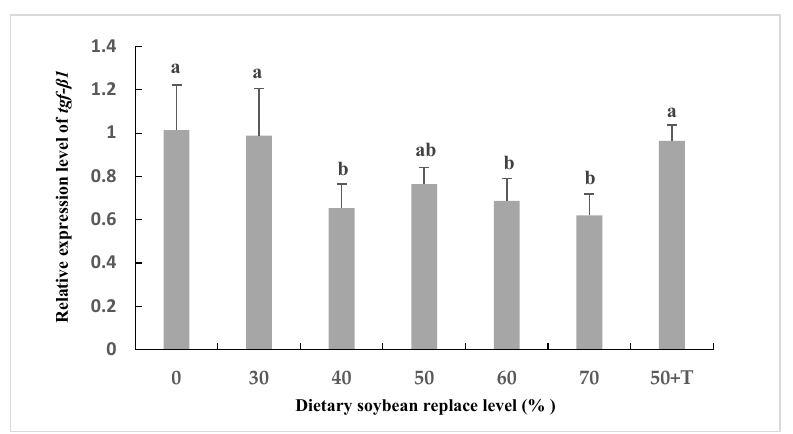
Figure 3. Relative expression of the mRNA for transforming growth factor β 1 ( tgf- β 1 ) in the liver of Oplegnathus punctatus fed the seven diets. Means in the same row with different superscripts are significantly different ( p < 0.05).